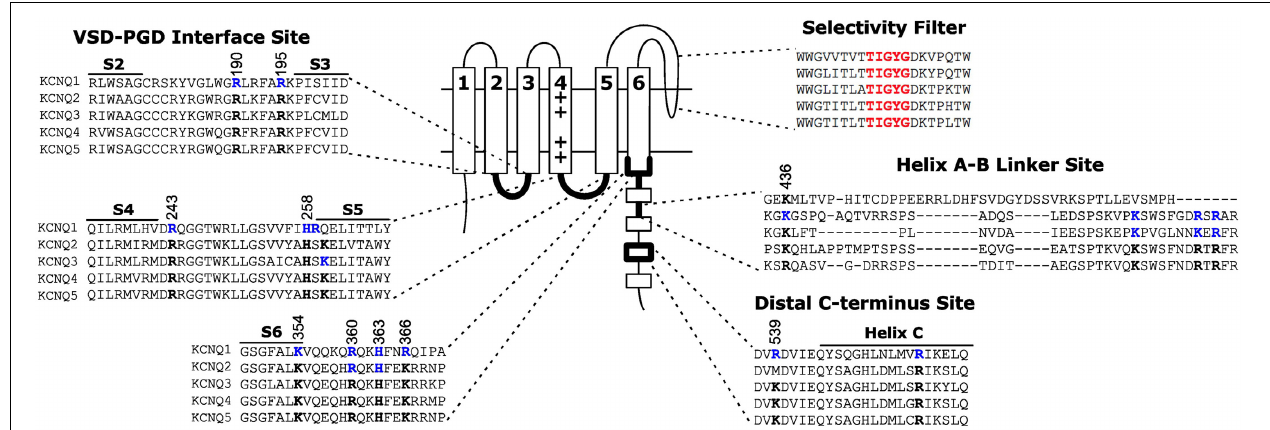
FIGURE 3 | Location of three proposed PIP 2 interacting sites on KCNQ. The VSD-PGD interface site includes contributions from the S2-S3 linker, S4-S5 linker, S6 and proximal C-terminus. Other sites have been proposed at the helix A-B linker or the distal C-terminus. Blue residues indicate residues